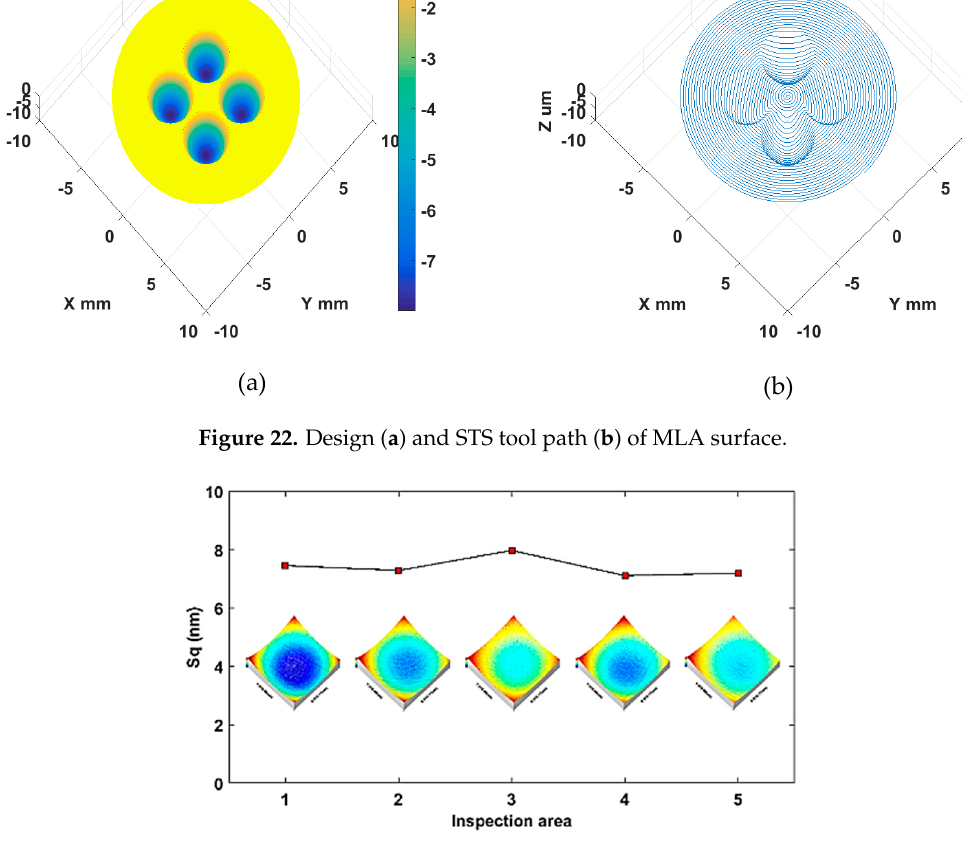
Figure 23. Topography distribution of MLA surface. Table 5. Surface topography S q by actual measurement and